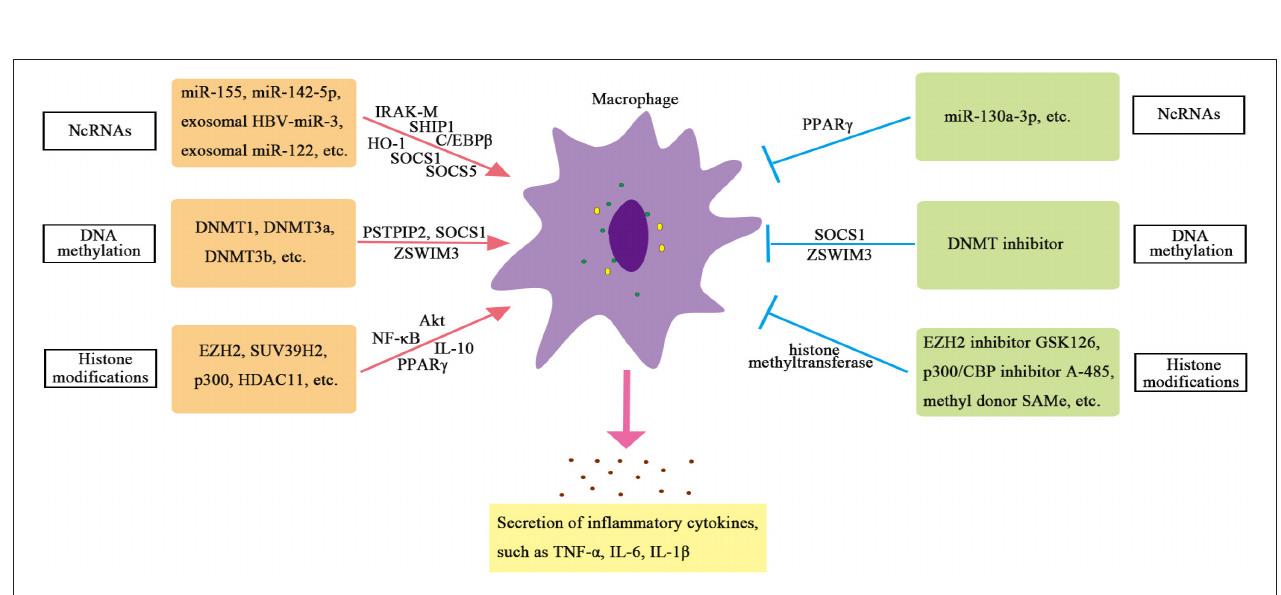
FIGURE 1 | Epigenetic regulation of hepatic stellate cell (HSC) activation.